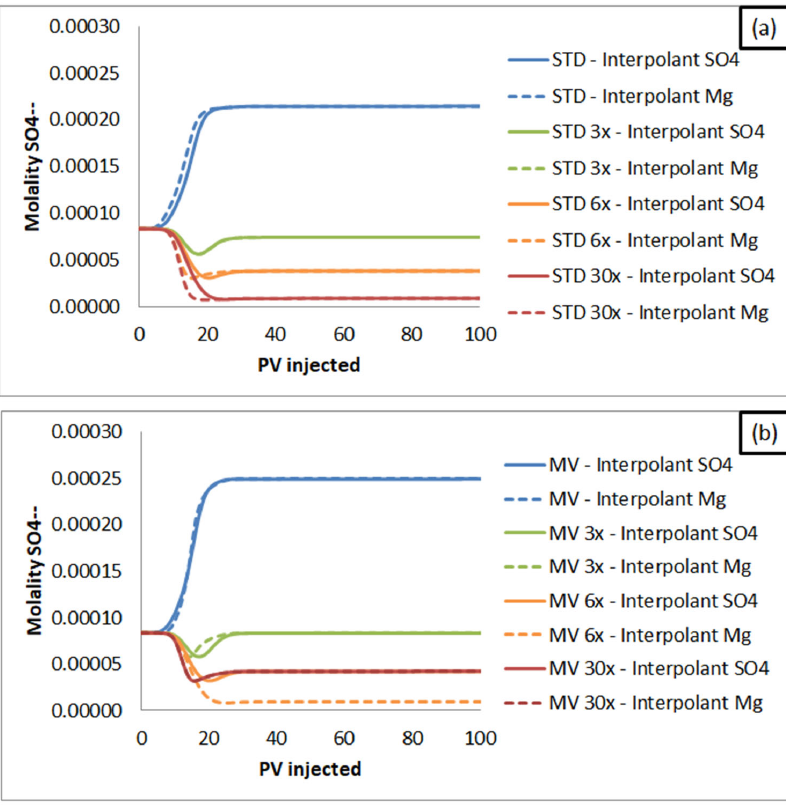
Figure 5. SO 42 − concentration in the effluent for brine injection: ( a ) STD; ( b ) MV and ( c ) DV.